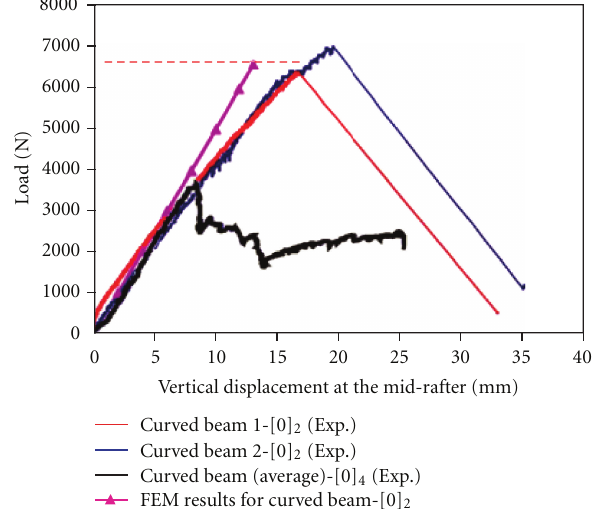
Figure 9: Typical load-displacement curves of the half-arch (case A) with two and four layers of full-length reinforcement compared to the FEM